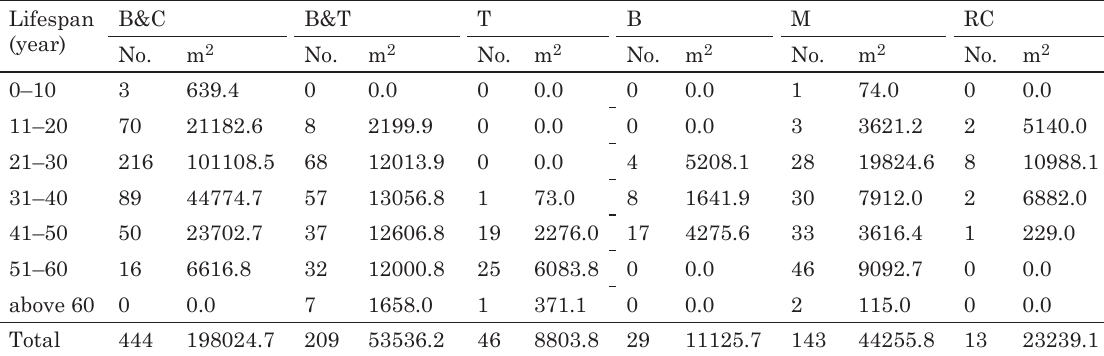
Table 5. Distribution of building lifespan by structure